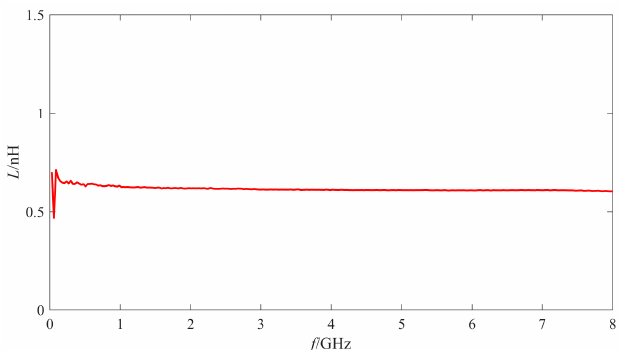
Figure 8. The inductance of one fabricated MEMS suspended inductor.